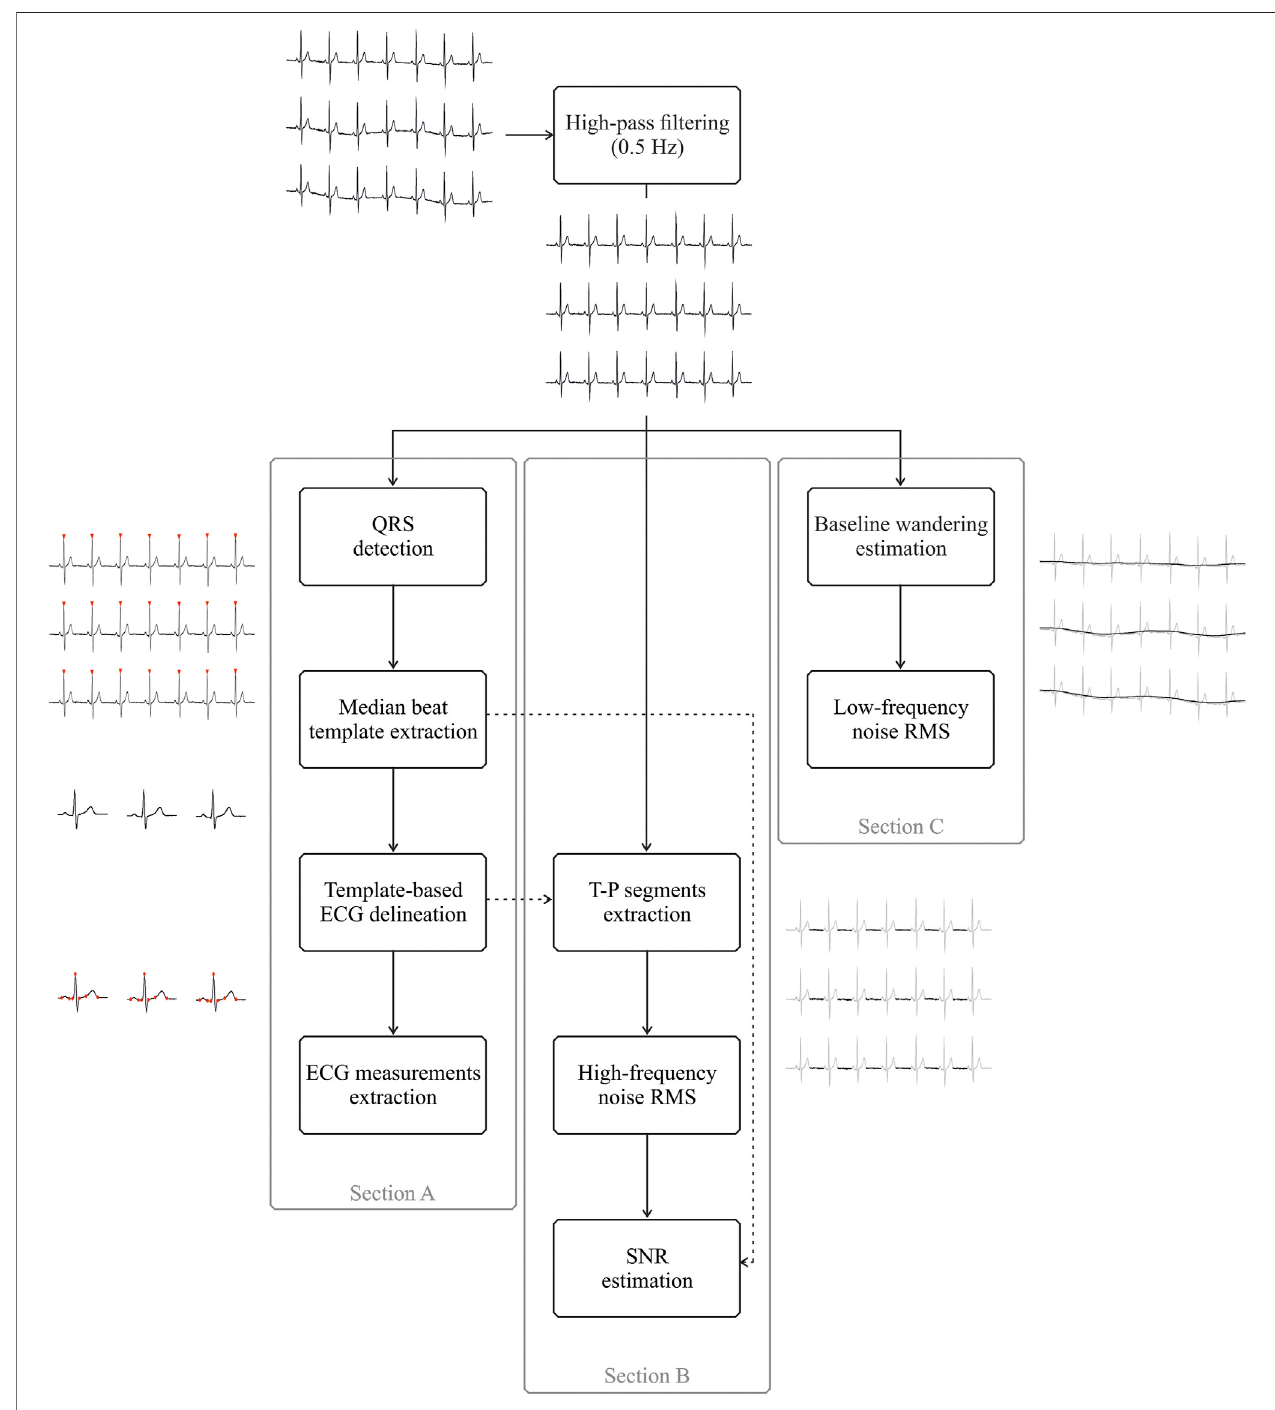
FIGURE 3 | Schematic representation of the different signal processing steps adopted for ECG measurement extraction (Section A) and for signal-to-noise ratio (SNR), high-frequency and low-frequency noise root-mean square estimation (Sections B and C, respectively). All sections share the same initial processing step, i.e., high-pass fi ltering at 0.5 Hz, despite the different purposes. Furthermore, the dashed arrow pointing from the template-based ECG delineation (Section A) to T − P segments extraction (Section B) indicates that T − P intervals were identi fi ed in high-pass fi ltered ECGs by exploiting T and P wave delineation on median beat templates,whereas thedashed arrow pointing fromthemedian beattemplate extraction (SectionA) toSNRestimation(SectionB)refers tothe adoption ofthepeak-to- peak amplitude of the median beat template for the SNR computation.